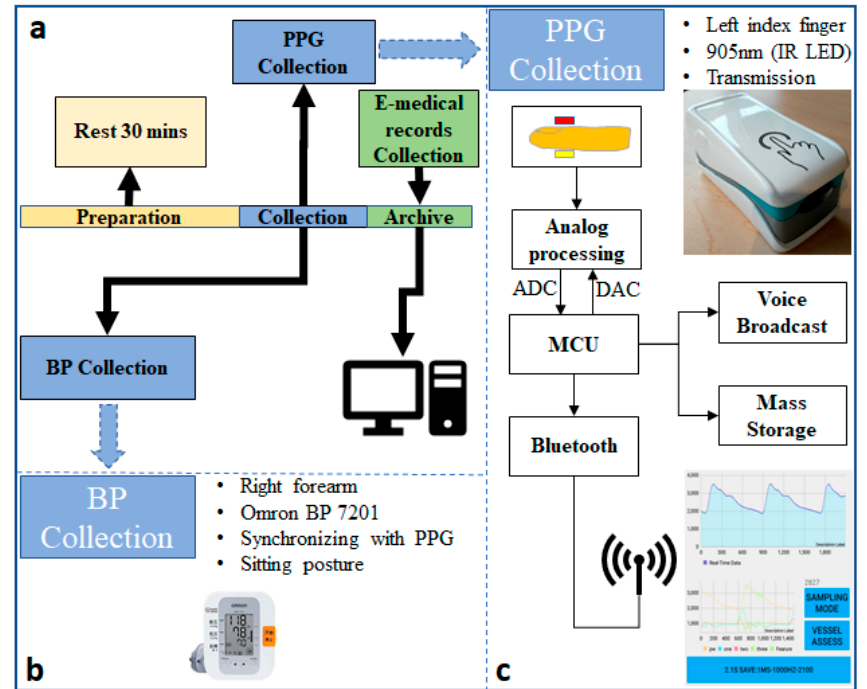
Figure 1. The block diagram of data collection. ( a ) Data collection protocol; ( b ) Blood pressure (BP) collection; ( c ) photoplethysmography (PPG) collection and the customized hardware platform.